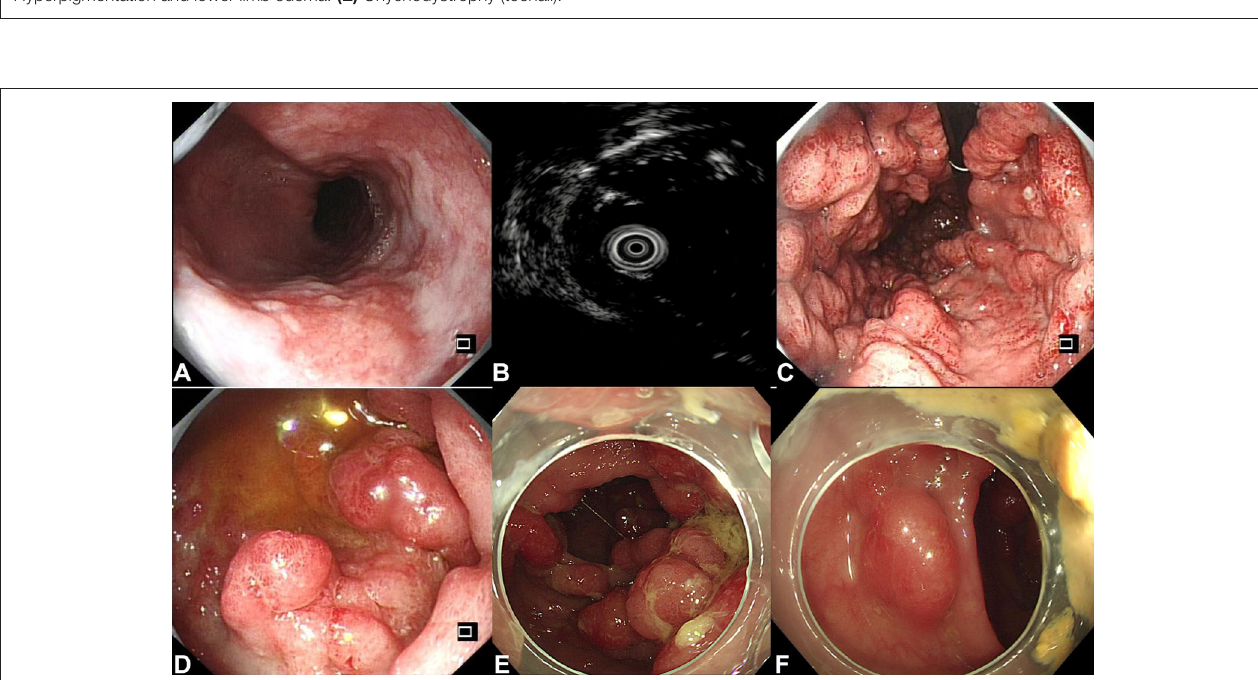
FIGURE 2 | Endoscopic images. (A) Esophageal lesion (at the 6 o’clock direction, size 2.2 × 1.0cm, type Paris 0-IIb). (B) Endoscopic ultrasound (EUS) confirmed the lesion originated from the mucosa layer. (C) Engorgement and hyperemia of gastric folds, as well as multiple polyps in the stomach (C) , duodenum (D) , and colon (E,F) , were